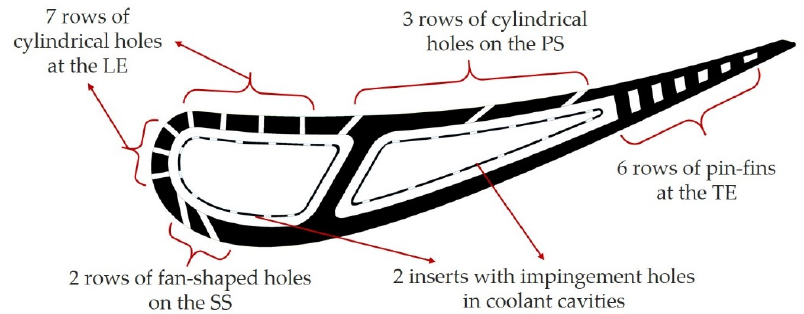
Figure 5. The geometry and cooling structure of a GE E3 1st Stage Vane.